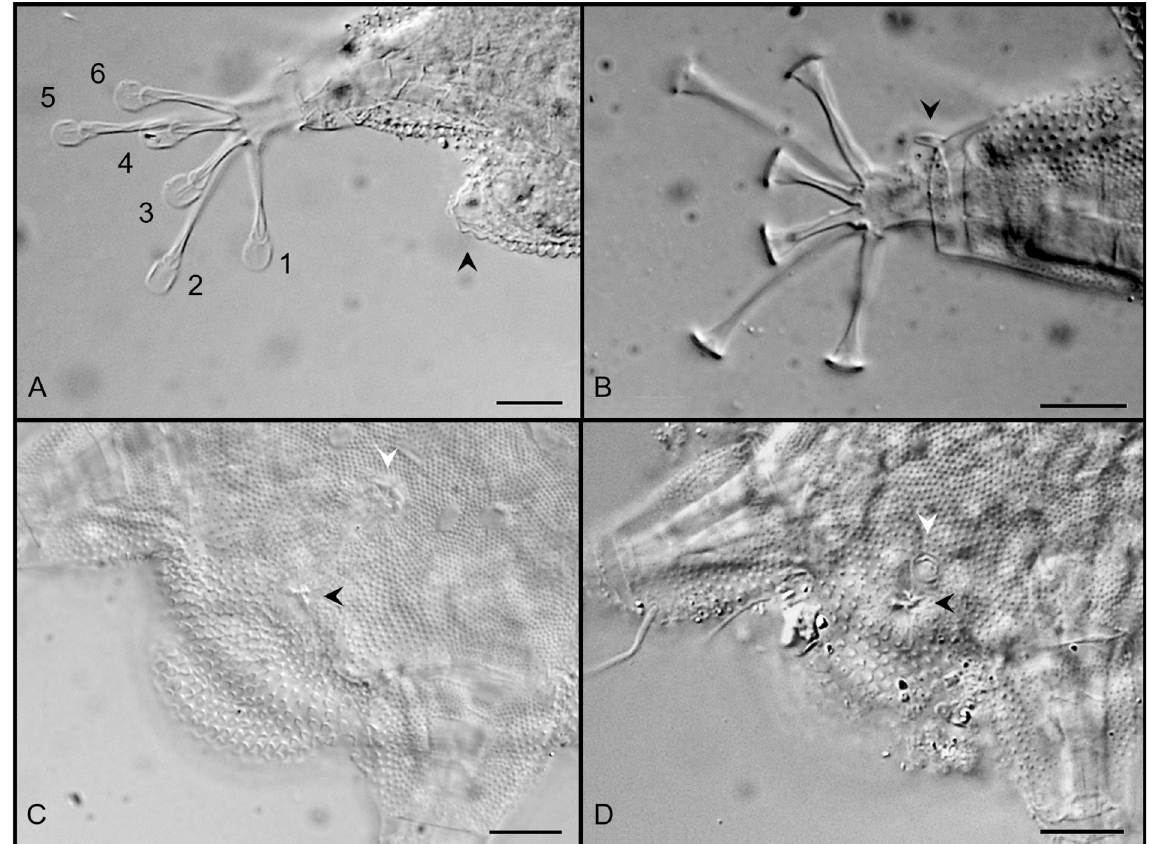
Fig. 6. Batillipes lusitanus sp. nov. A . Fourth leg of a paratype (slide C.IX-46) with details of toes (1–6), note the shape of the ventro-lateral projection between legs III–IV (black arrowhead). B . Fourth leg of a paratype (slide C.IX-1), showing the rigid process on the distal extreme (black arrowhead). C . Female gonopore (white arrowhead) and anus (black arrowhead). D . Male gonopore (white arrowhead) and anus (black arrowhead). Scale bars = 10